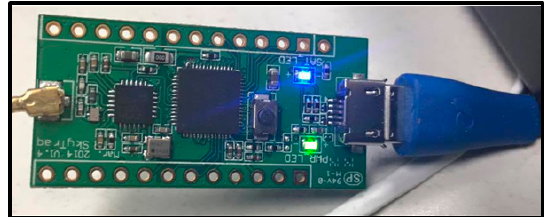
Figure 16. GPS timing Module.